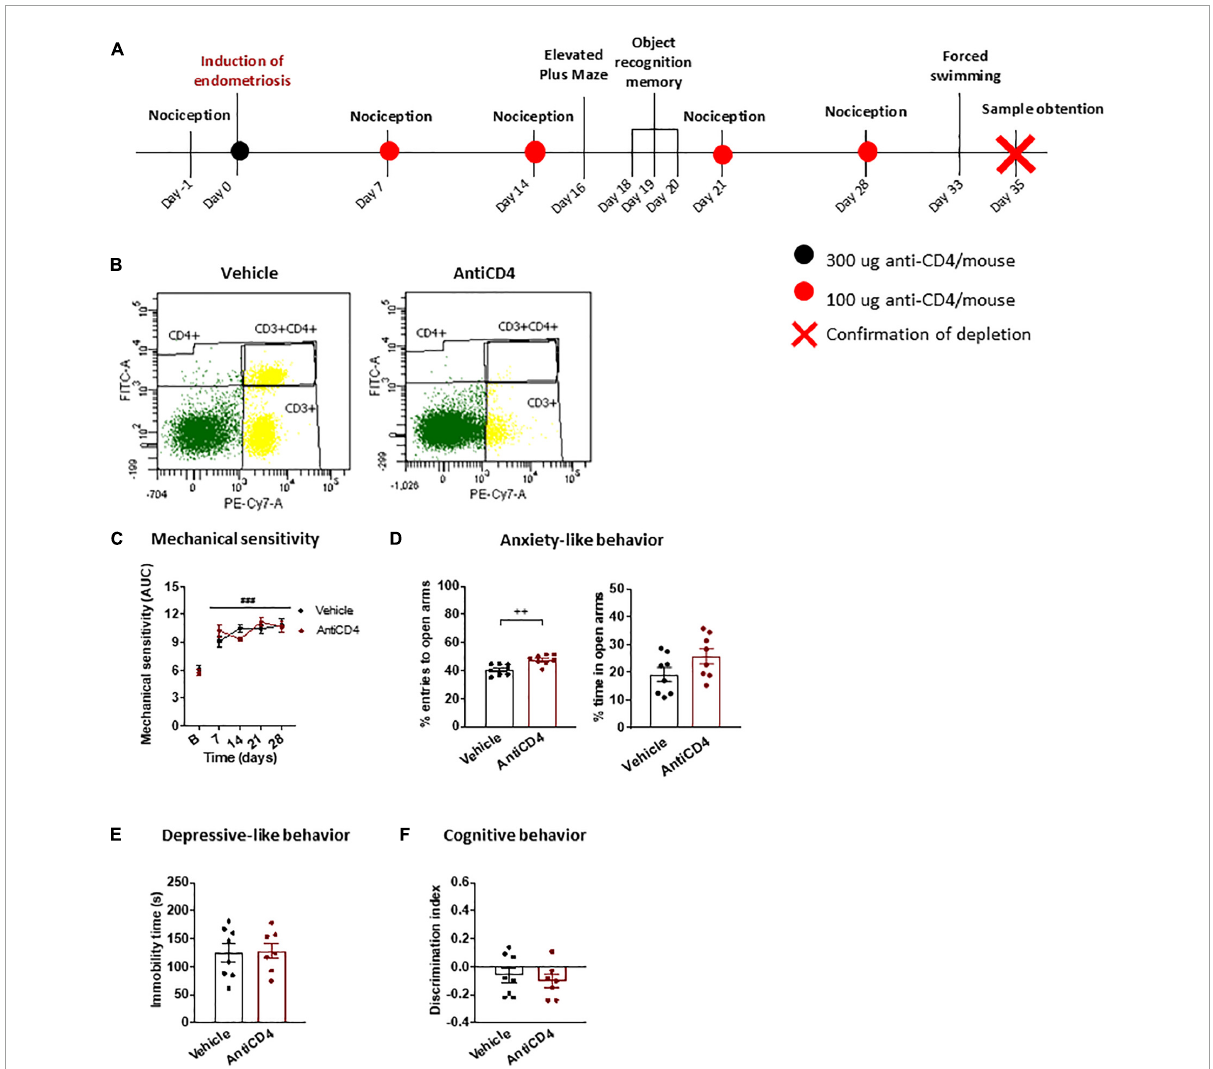
FIGURE2 Behavioral effects of CD4 + cell depletion on endometriosis mice. (A) Timeline of the behavioral experiment and sample collection. (B) Splenic flow cytometry confirmed depletion of CD4 + cells. (C) Endometriosis mice treated with vehicle or antiCD4 antibody showed similar mechanical hypersensitivity after stimulation with von Frey filaments. (D) Depletion of CD4 + cells decreased anxiety-like behavior revealed by increased percentage of entries to the open arms of the elevated plus maze. (E) Depressive-like behavior in the forced swimming test was unaffected by CD4 + cell depletion. (F) Cognitive behavior in the object recognition task was similar regardless of CD4 + cells. Error bars are mean ± SEM. (C) Repeated measures ANOVA, (D–F) Student’s t -test. ### p < 0.01 vs baseline; ++ p < 0.01 vs vehicle. AUC, area under the curve; FITC-A, Fluorescein isothiocyanate A; PE-Cy7-A, R-phycoerythrin-Cyanine